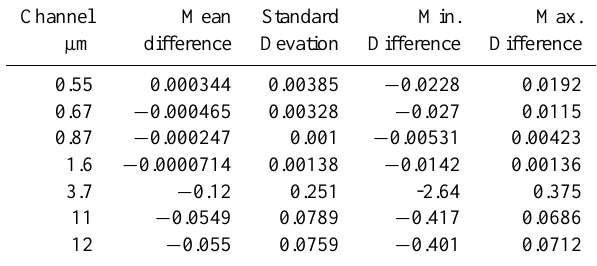
Table 5. This table summarises the differences between the Fast Forward Model and DISORT, the visible channel units are re- flectance and the infrared channel units are in